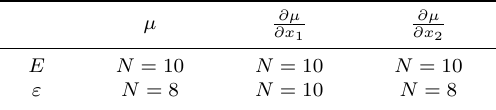
Table 7. The optimized value of N for obtaining the numerical solutions µ,∂µ/∂x 1 ,∂µ/∂x 2 of best error E and efficiency number ε for Case 3. ∂µ µ ∂µ ∂x 1 ∂x 2 E N = 10 N = 10 N = 10 ε N = 8 N = 10 N = 8